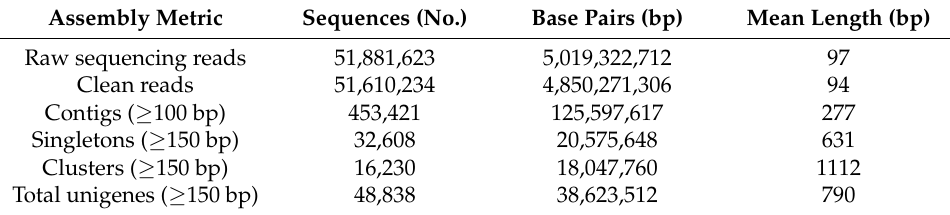
Table 1. Summary of sequence assembly.